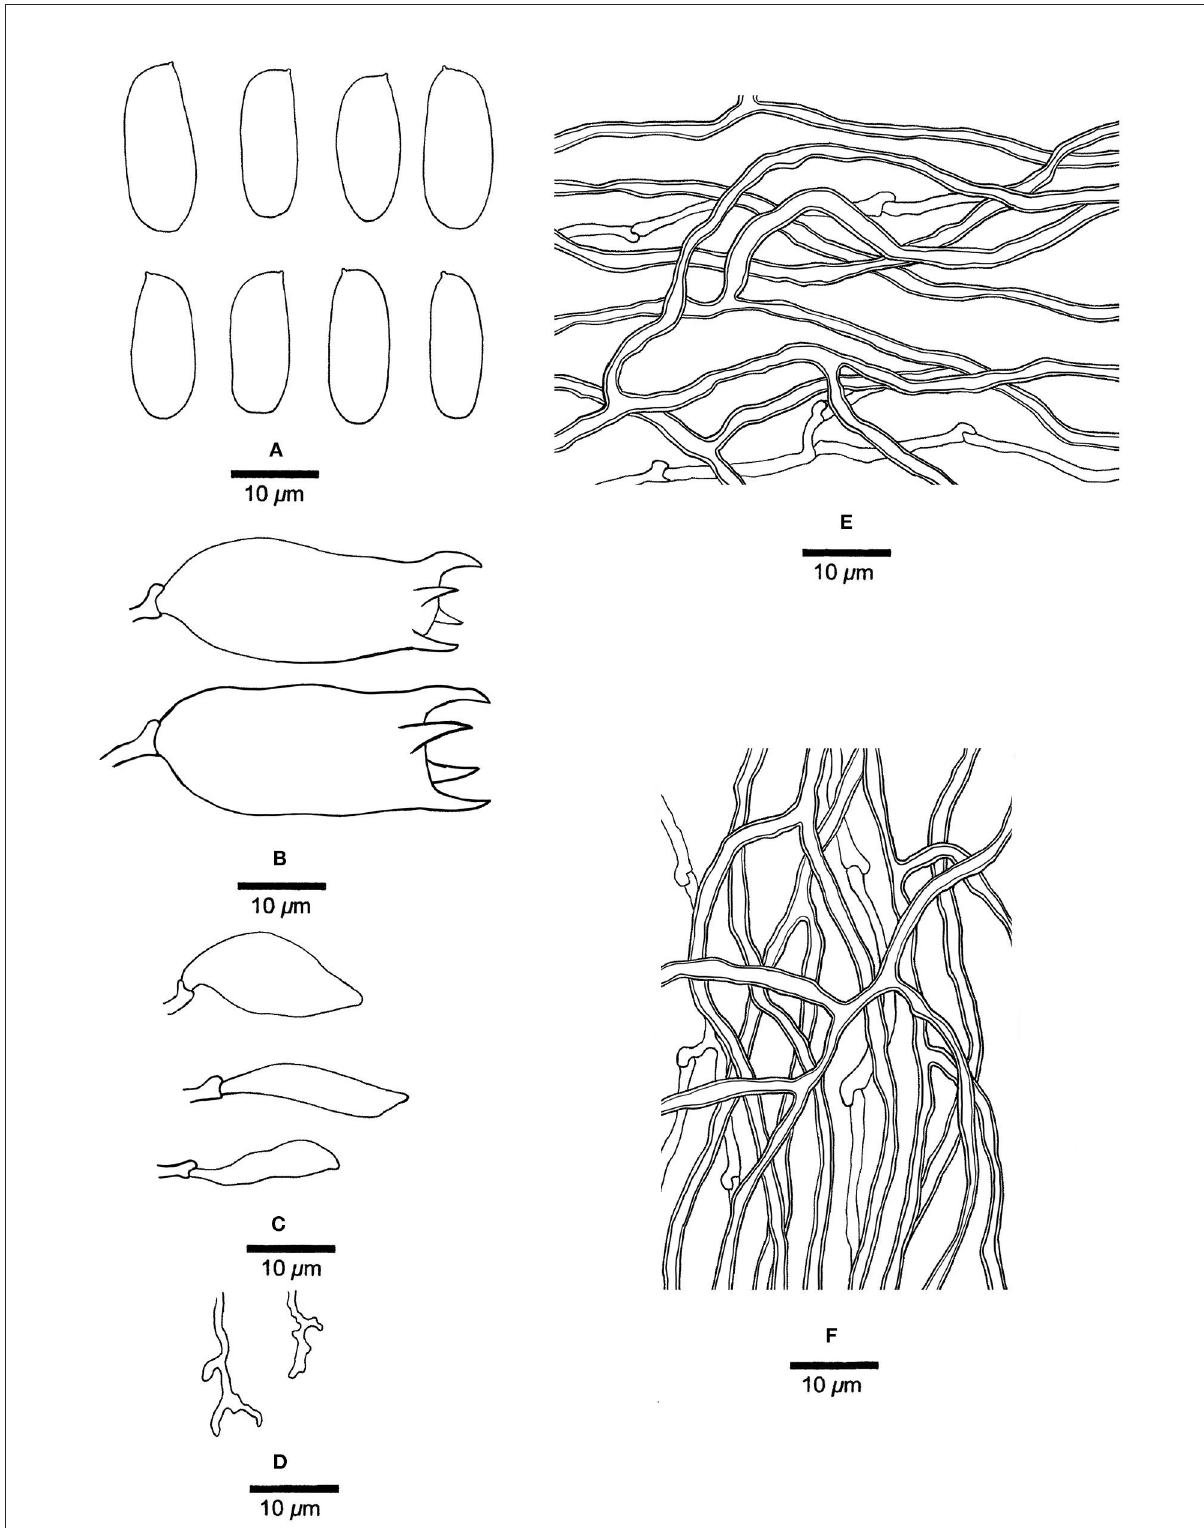
FIGURE8 Microscopic structures of Jorgewrightia kirkii (drawn from Ryvarden 32577). (A) Basidiospores. (B) Basidia. (C) Cystidioles. (D) Dendrohyphidia. (E) Hyphae from subiculum. (F) Hyphae from tube